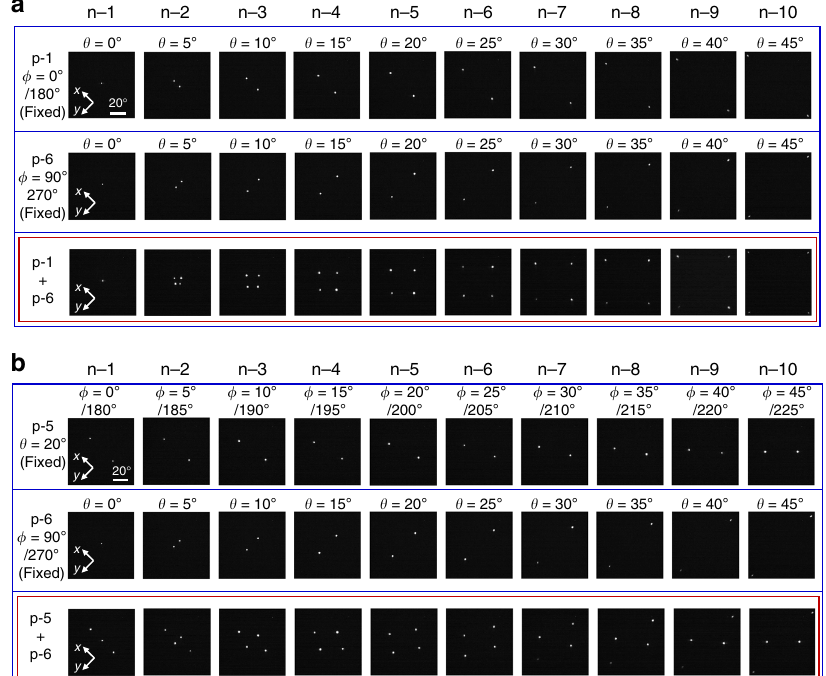
Fig. 6 Demonstration of 2D beam scanning by selective driving of elements of the 10 × 10 matrix array. a (Top two rows) Scanning polar angles (from θ ¼ 0 (cid:4) to 45 (cid:4) ) with fi xed azimuthal angles ( ϕ ¼ 0 (cid:4) = 180 (cid:4) or 90 (cid:4) = 270 (cid:4) ). (Bottom row) Parallel 2D beam scanning of both top rows simultaneously. b (Top row) Scanning azimuthal angles (from ϕ ¼ 0 (cid:4) = 180 (cid:4) to 45 (cid:4) = 225 (cid:4) ) with fi xed polar angle θ ¼ 20 (cid:4) . (Middle row) Scanning polar angles (from θ ¼ 0 (cid:4) to 45 (cid:4) ) with fi xed azimuthal angle ϕ ¼ 90 (cid:4) = 270 (cid:4) . (Bottom row) Parallel 2D beam scanning of both top and middle rows